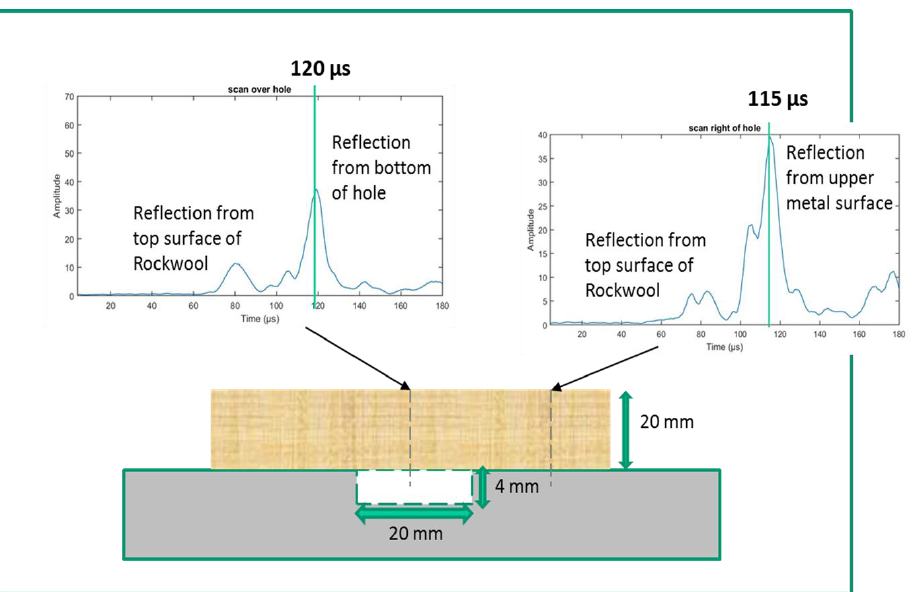
Figure 8. Pulse compression outputs for two locations above a metal surface containing a 4 mm deep flat-bottomed hole. The sample was covered in a 20 mm thick layer of water-saturated Rockwool insulation.